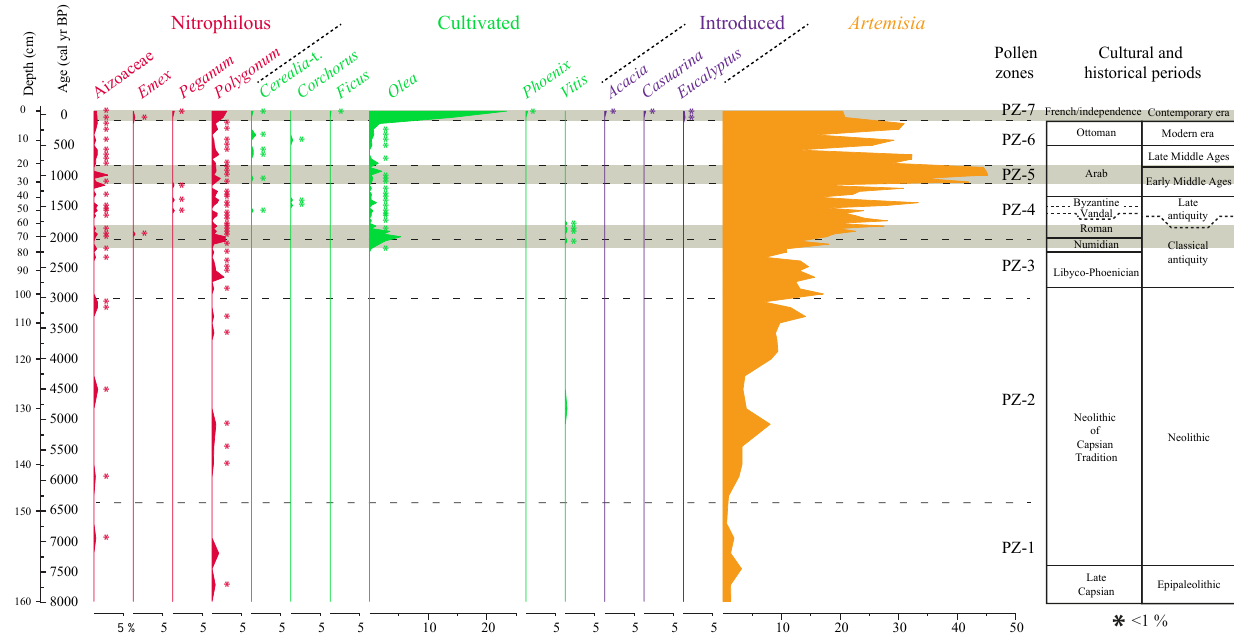
Figure 5. Detailed pollen diagram showing the evolution of Artemisia and selected anthropogenic pollen indicators (APIs) including cul- tivated ( Cerealia -t., Corchorus , Ficus , Olea , Phoenix , Vitis ), nitrophilous (Aizoaceae, Emex , Peganum , Polygonum ) and introduced ( Acacia cyanophylla -t., Casuarina , Eucalyptus ) plant taxa. Grey bars highlight periods of enhanced human pastoral and/or agricultural activities. Table on the right side indicates the main cultural and historical subdivisions of Tunisian